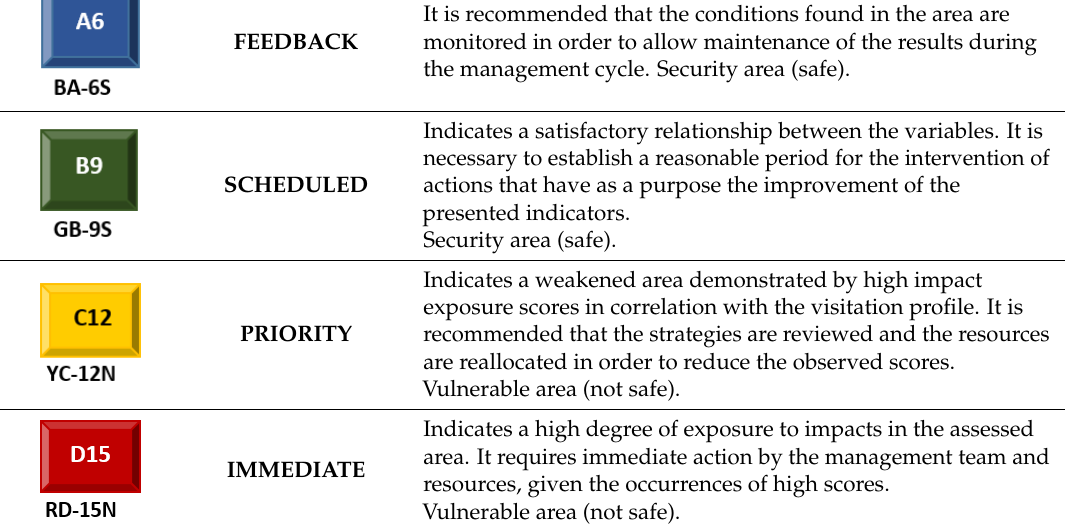
Table 2. Alphanumeric Concept of Quadrant Risk Classification and Management Action.